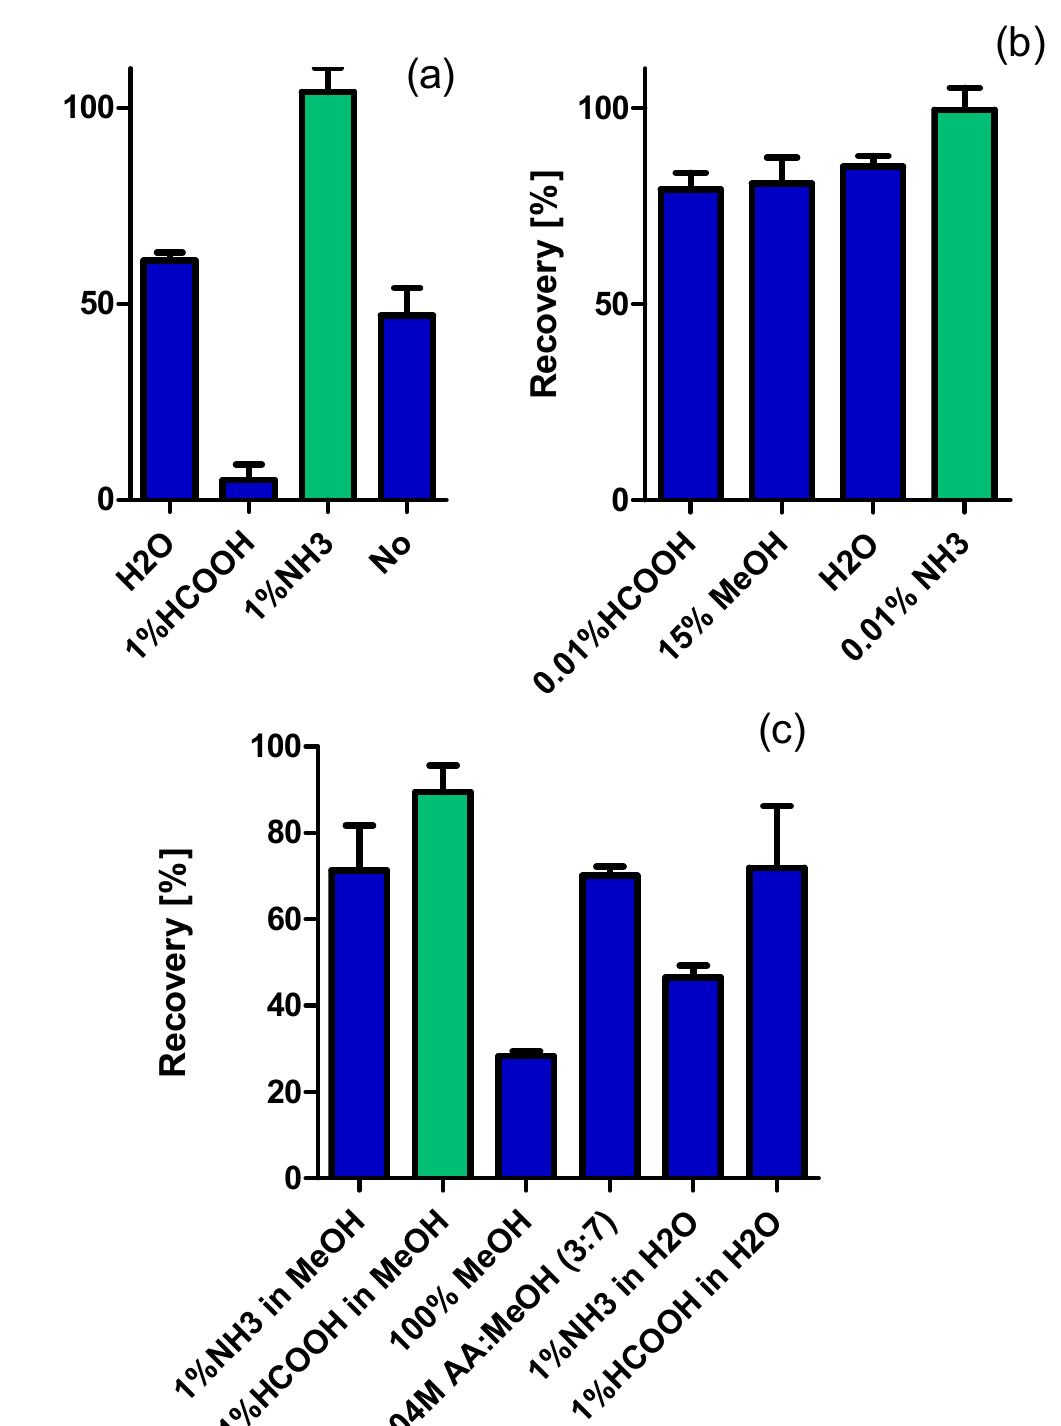
Figure A1. Recoveries of tyramine in analysis of m-d-SPE process: loading ( a ), washing ( b ) and eluting ( c ) steps.